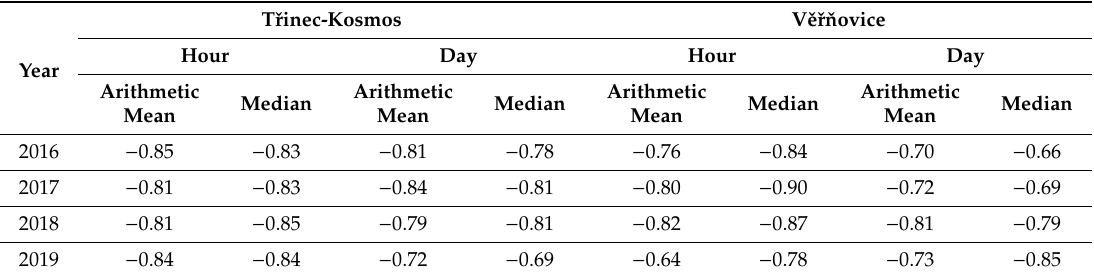
Table 2. The mixing layer height values at the T ř inec-Kosmos and V ěřň ovice sites, 2016–2019.